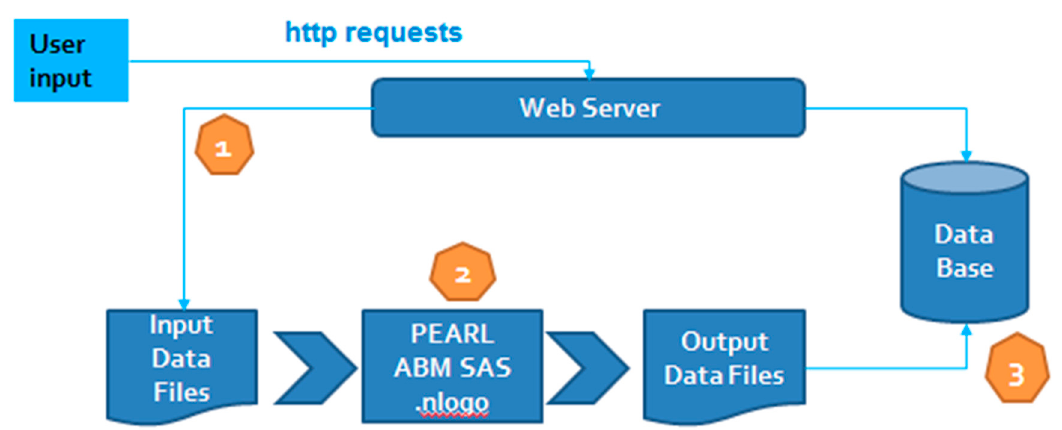
Figure 8. Online interface link to NetLogo, database and web server. 1. Web Server creates Input data Figure 2. ABM parses input data file, simulates the decision making and creates output data file with results (process is triggered by Web Server) and 3. With the help of the Web Server results are inserted in the database, ready to be shown to the user.